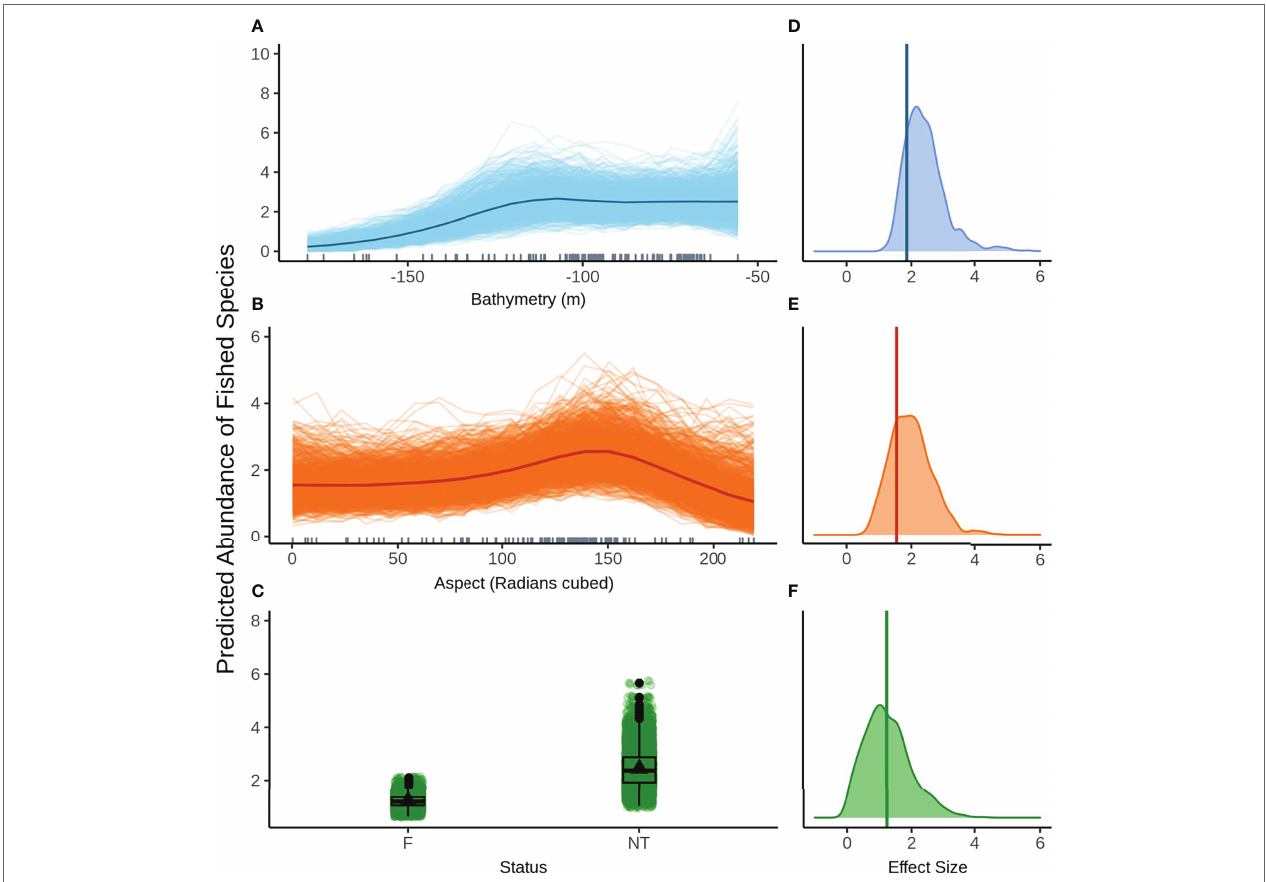
FIGURE 5 | Predicted values for the second ranked model for abundance of fished species when field of view variables were not included - (A) bathymetry (m), (B aspect (radians cubed), (C) status (F, fished areas; NT, no take area). Density plots of effect size are also plotted for each aforementioned predictor – (D−F) respectively – with a vertical line indicating the frequentist effect size